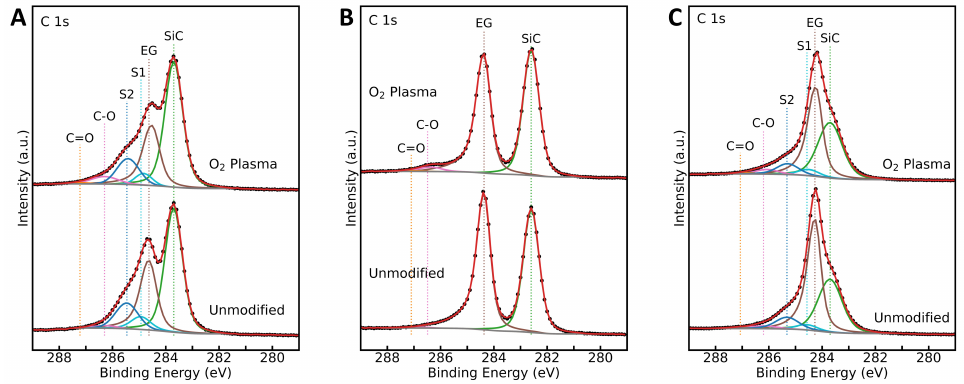
Figure 4. XPS for C 1s comparing oxygen plasma and unmodified samples for ( A ) monolayer EG, ( B ) hydrogen-intercalated QFS bilayer EG, and ( C ) multilayer EG. After oxygen plasma exposure, the percent area of the C 1s peak corresponding to C-O and C=O bonds increased, while that of the “EG” peak decreased for all EG types, suggesting the removal of sp 2 graphene and formation of C=O and C-O functional